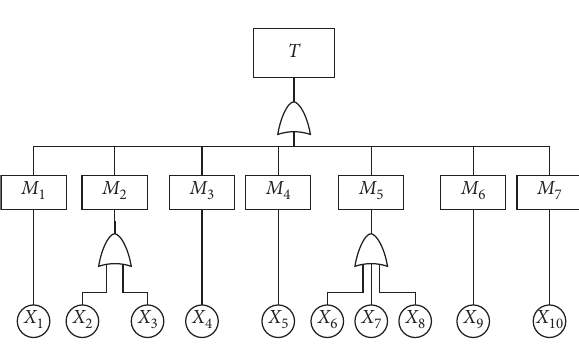
Figure 1: A diagram of the escalator structure.